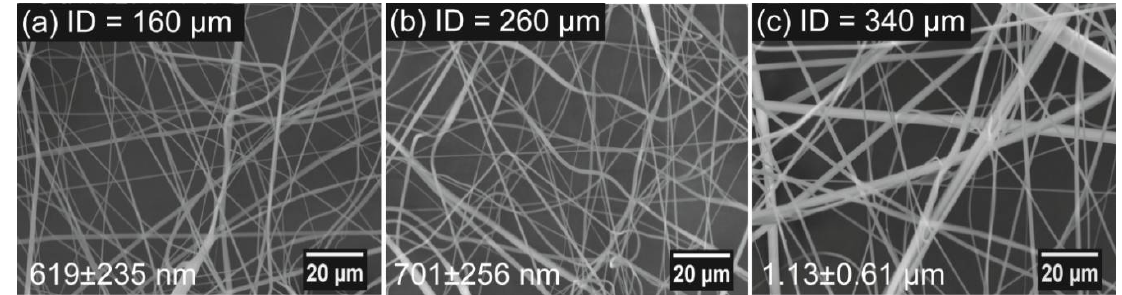
Figure 7. Scanning electron microscope images of centrifugally spun of rPET fibers prepared using needles with various inner diameters: ( a ) 160 μm; ( b ) 260 μm; and ( c ) 340 μm. Centrifugal spinning condition: polymer solution concentration, 10 wt %; rotation speed, 15,000 rpm; collection distance, 10 cm. Table 1. Mechanical properties of rPET fibers produced from various polymer solutions. rPET Concentration (wt %)